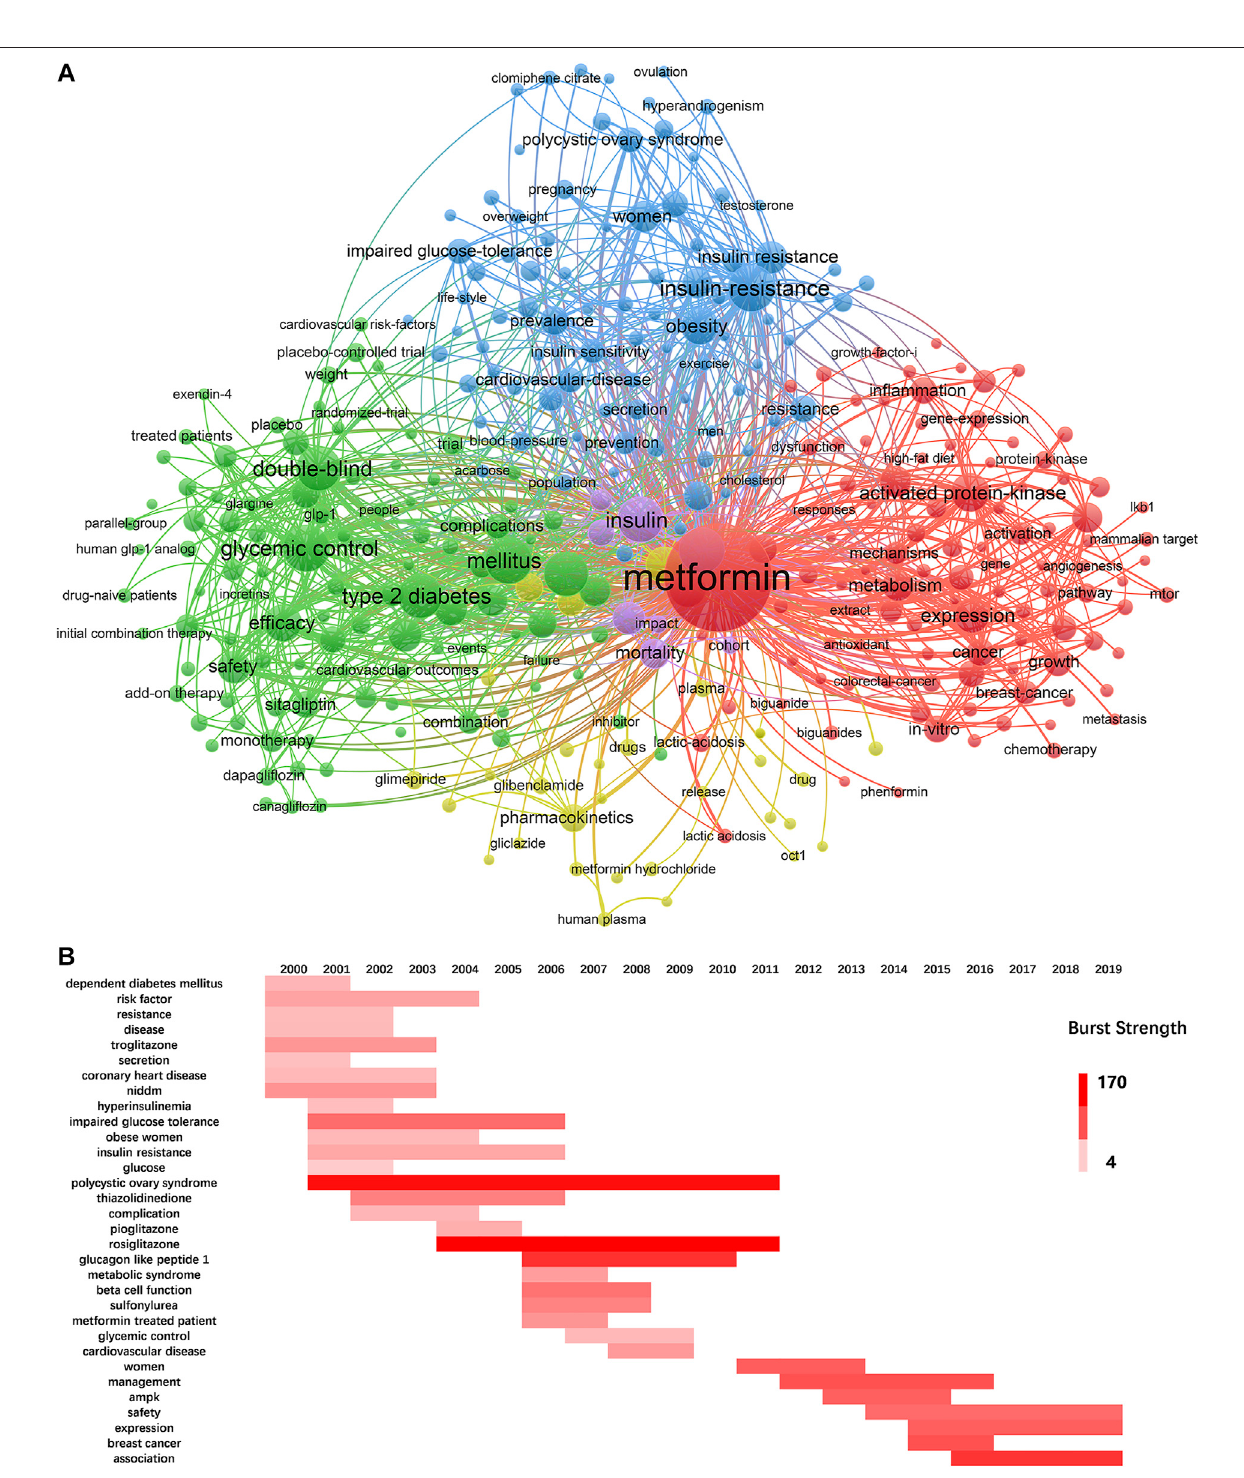
FIGURE 6 | Keywords analysis. (A) The cluster analysis of keywords with an occurrence more than 100 in metformin area, 1980 – 2019. (B) The burst detection of keywords of metformin area in a chronological order, 2000 – 2019.